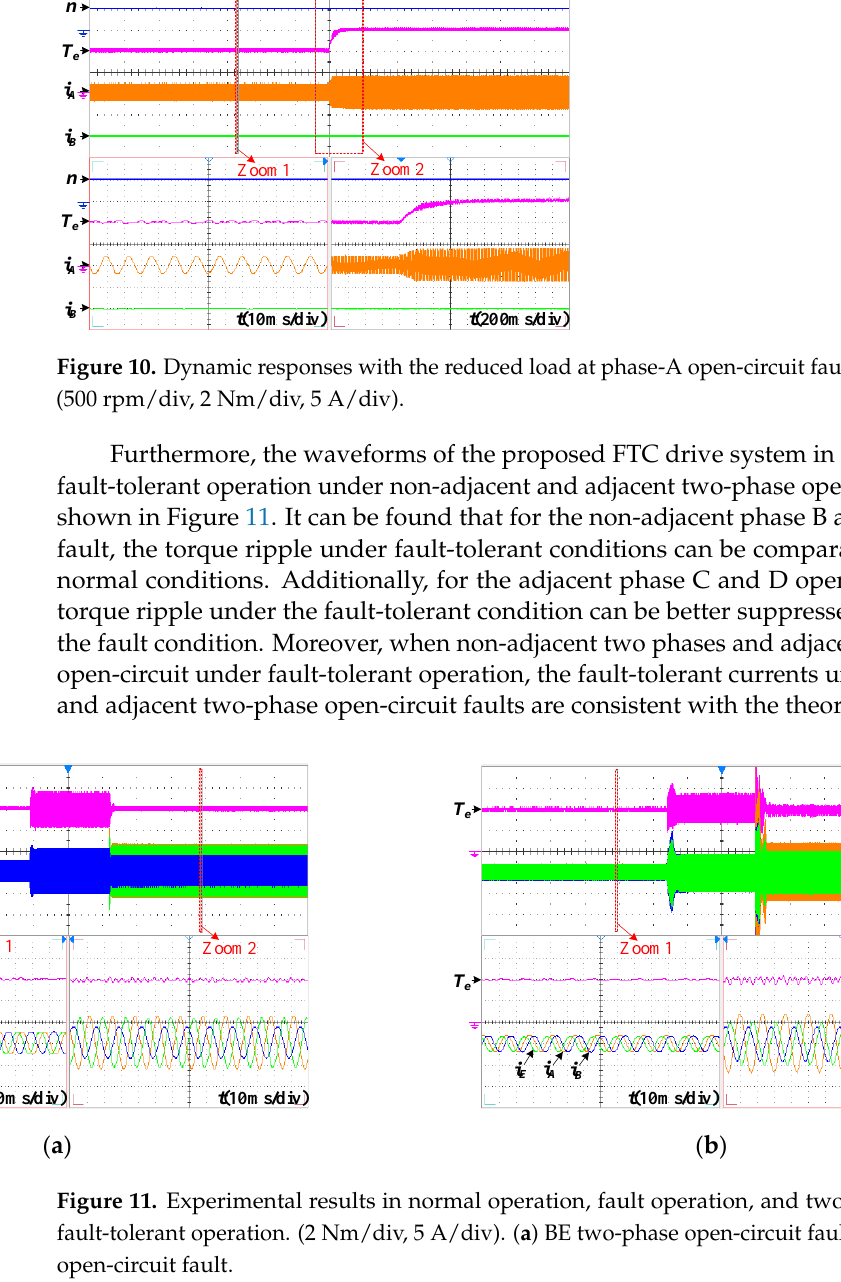
Figure 9. Dynamic responses with the reduced load at phase-A open-circuit fault-tolerant operation. (500 rpm/div, 2 Nm/div, 5 A/div). ( a ) Conventional fault-tolerant FOC. ( b ) Proposed fault-tolerant FOC.